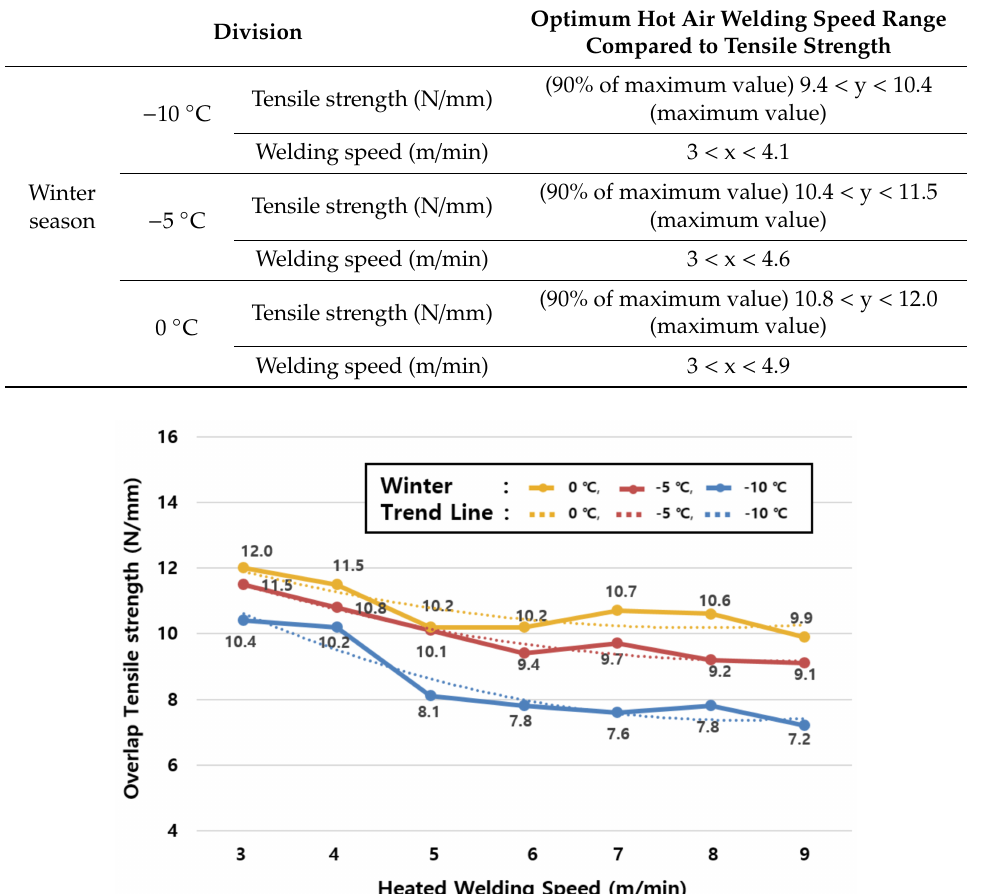
Figure 8. Analysis of optimum hot air welding speed by temperature in